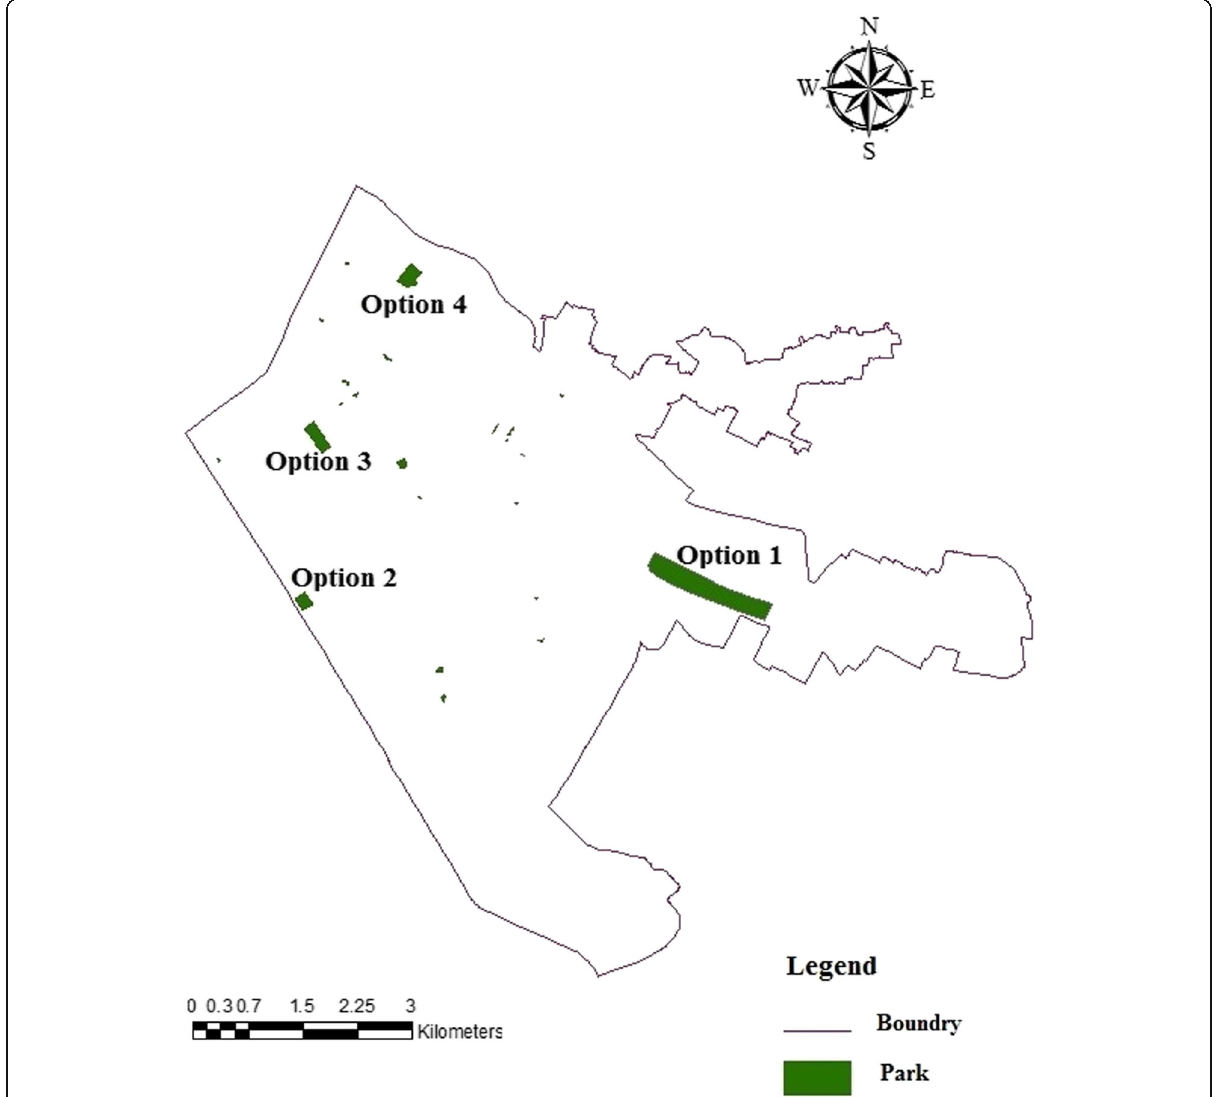
Fig. 12 Suitable locations map for accommodation in the